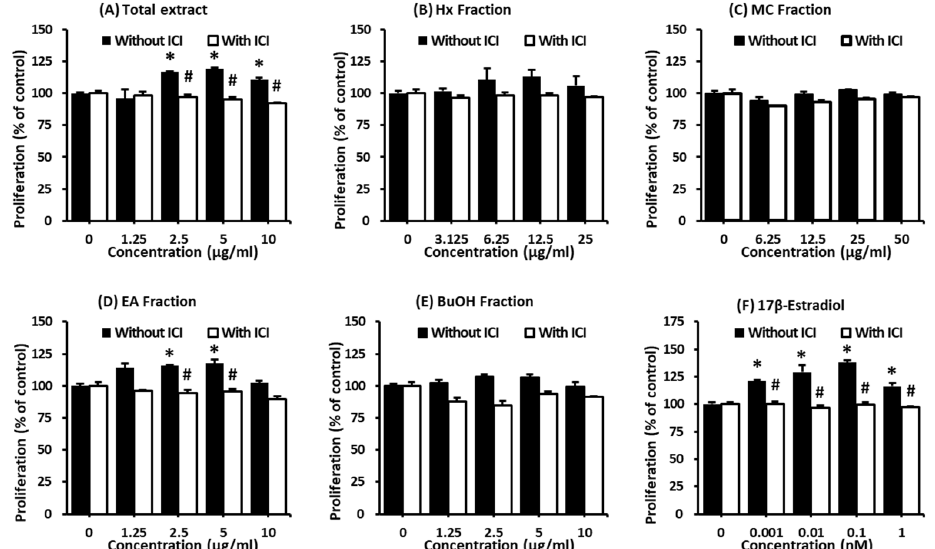
Figure 1. Comparison of the estrogenic activity of the ( A ) crude extract (total); ( B ) hexane (Hx), ( C ) CH 2 Cl 2 (MC), ( D ) EtOAc (EA), and ( E ) n -BuOH (BuOH) fractions; and ( F ) 17 β -estradiol in the absence or presence of ICI 182,780 according to the cell proliferation measured by E-screen assay in MCF-7 cells. * Significant difference between the cells treated with the extract or fractions and untreated cells. # Significant difference between the cells treated with ICI and without ICI at the same concentration of sample ( n = 3 independent experiments, p < 0.05, Kruskal–Wallis non-parametric test). Data are represented as the mean ± standard error of the mean (SEM).